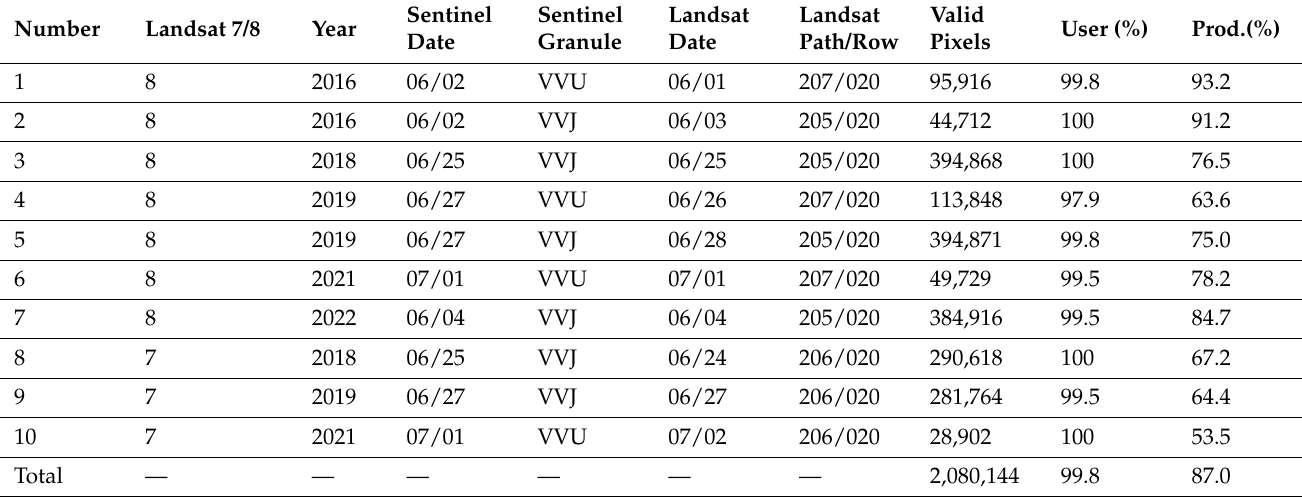
Table 4. Details of all the images used in accuracy verification. Sentinel and Landsat date are the date of the Sentinel and Landsat images used, respectively (month/day). Valid pixels indicates the number of valid Landsat pixels overlaying the study sites that are covered by both the specified Landsat and Sentinel image. User and Prod. indicate User and Producer accuracy for that image,